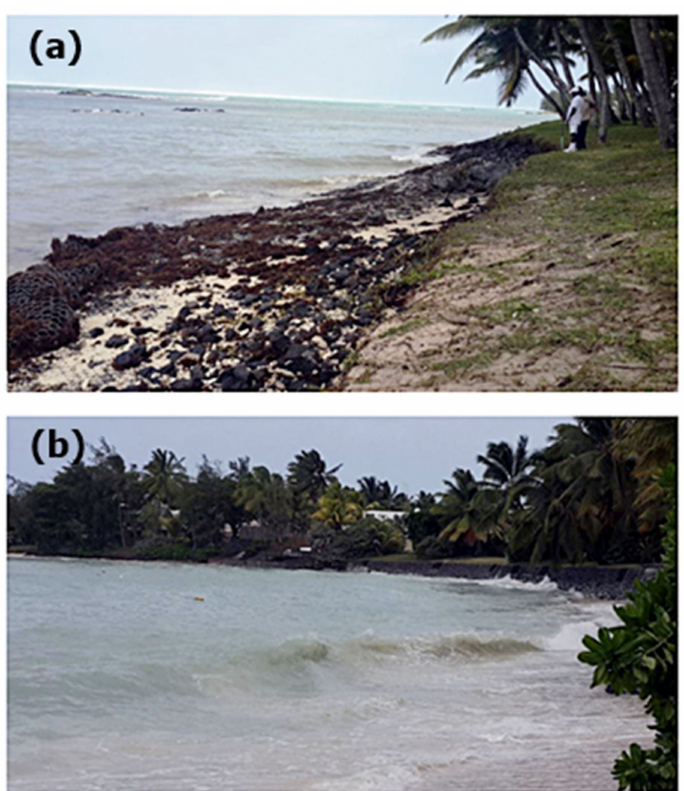
Figure 12. ( a ) Damaged beach with exposed rock-filled gabion baskets after cyclone Berguitta in January 2015. ( b ) The dominant wave at the study site drives a net transport to the